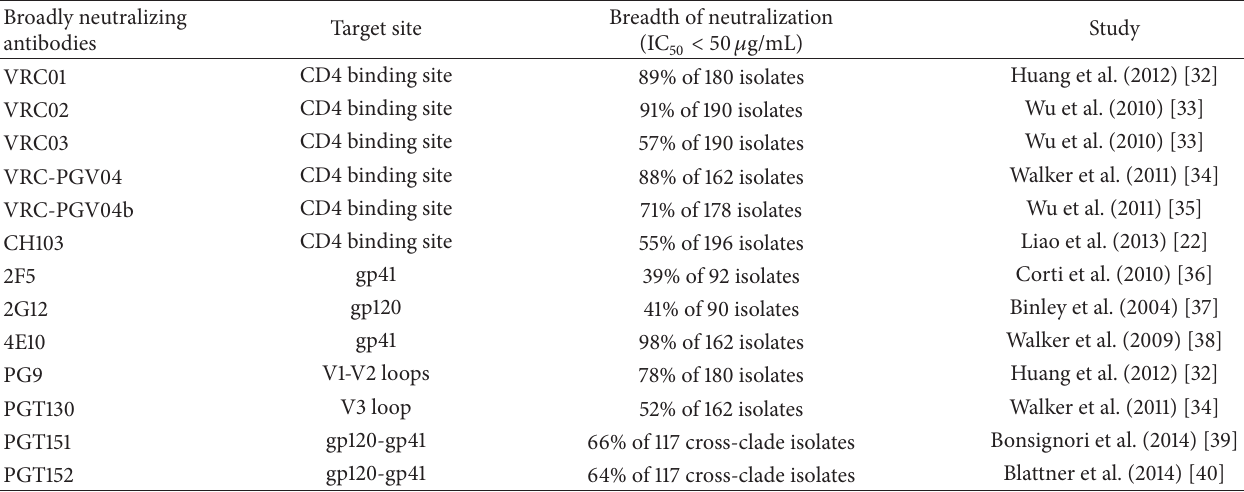
Table 2: Broadly neutralizing antibodies, target sites, and breadth of neutralization. Broadly